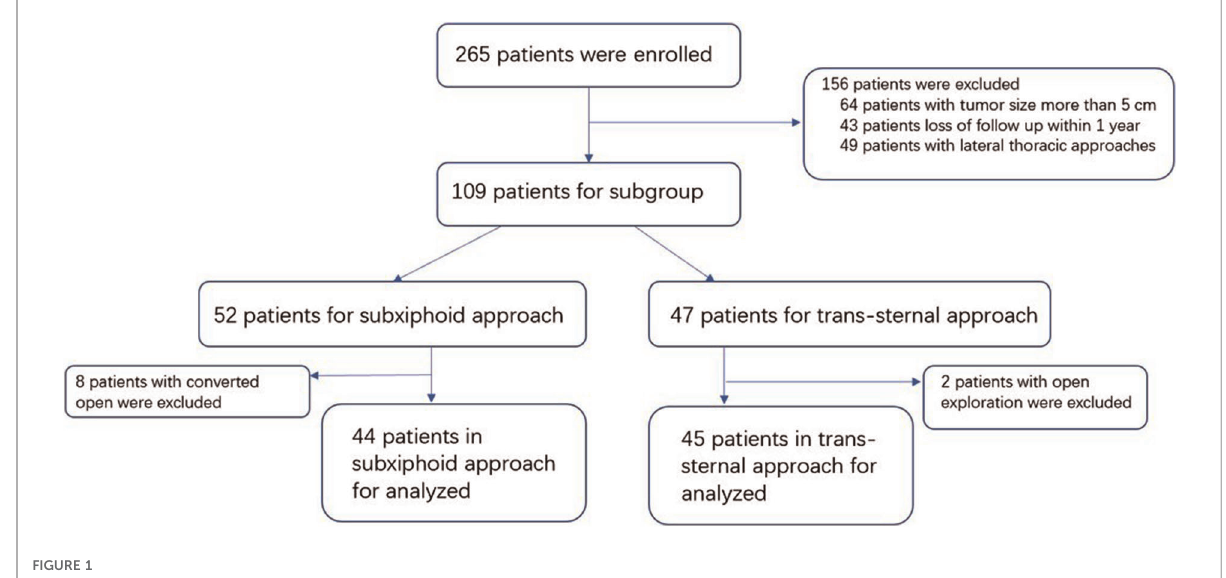
FIGURE 1 Flowchart of patient disposition.